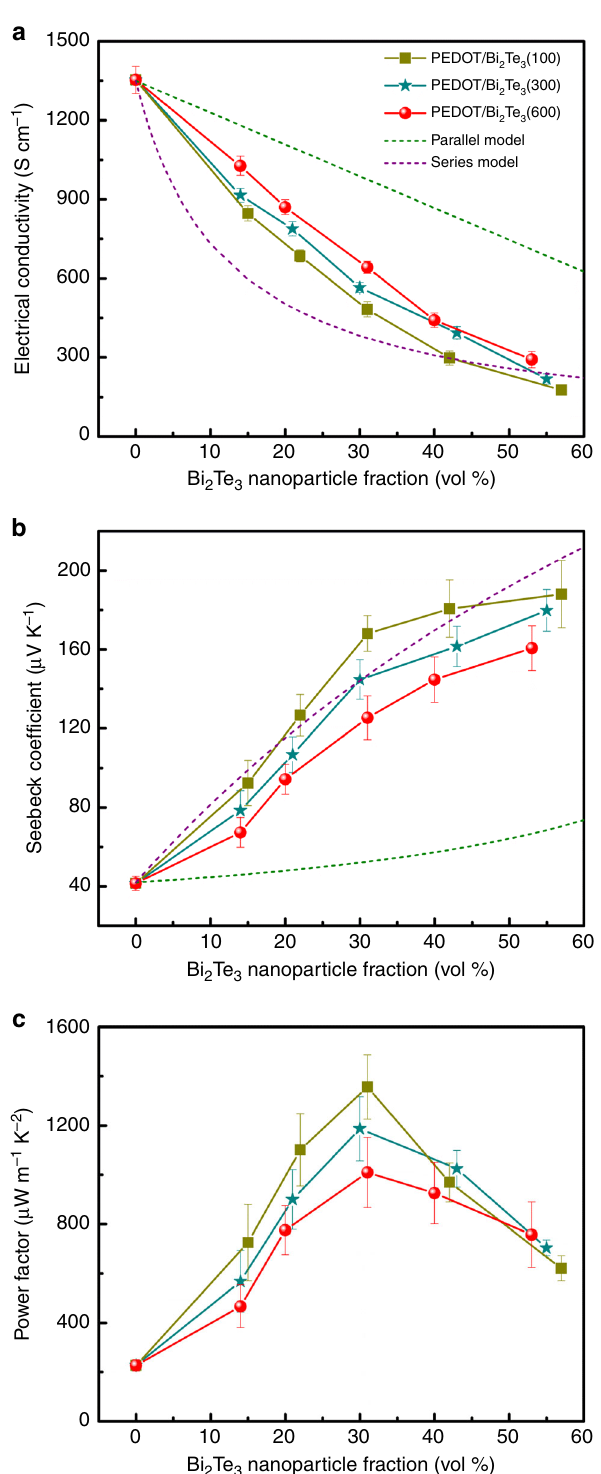
Fig. 3 In-plane electrical conductivity, Seebeck coef fi cient, and power factor. a Electrical conductivity of PEDOT/Bi 2 Te 3 hybrid fi lms as a function of Bi 2 Te 3 nanoparticle fraction. b Seebeck coef fi cient of PEDOT/Bi 2 Te 3 hybrid fi lms as a function of Bi 2 Te 3 nanoparticle fraction. c Power factor of PEDOT/Bi 2 Te 3 hybrid fi lms as a function of Bi 2 Te 3 nanoparticle fraction. Each point shows the standard deviations from three